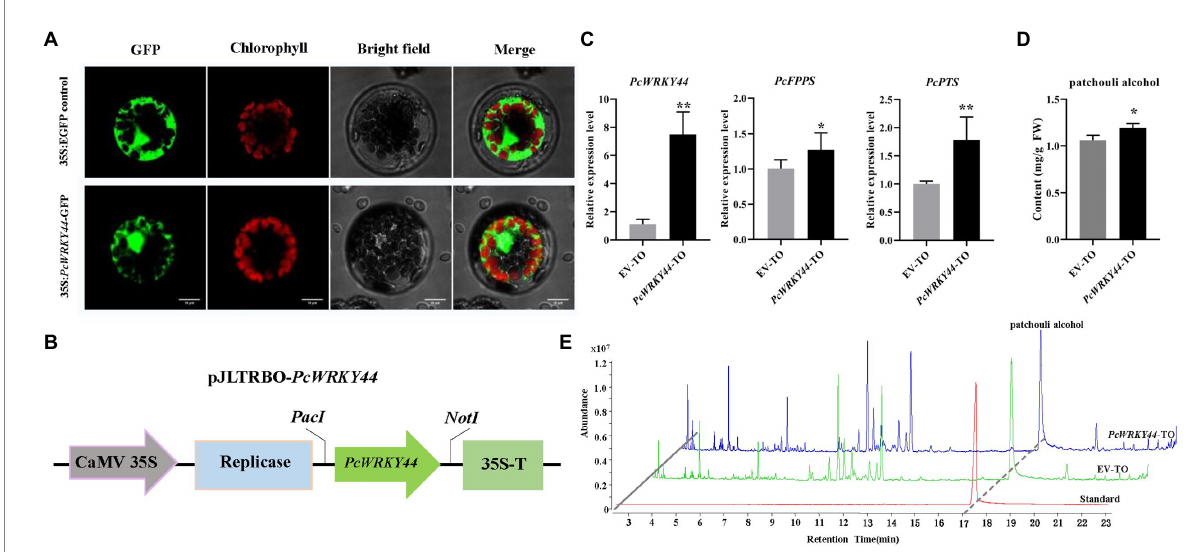
FIGURE 7 PcWRKY44 localized in the nucleus and transient overexpression of PcWRKY44 increased the accumulation of patchouli alcohol in P. cablin leaves. (A) Subcellular localization analysis of the 35S: PcWRKY44 -GFP fusion protein in Arabidopsis protoplasts. (B) Model of the pJLTRBO- PcWRKY44 constructs. The ORF of PcWRKY44 was cloned into the pJLTRBO vector with the restriction enzyme sites PacI and NotI . (C) The relative expression levels were analyzed by RT-qPCR for PcWRKY44 , PcFPPS, and PcPTS in EV-TO and PcWRKY44 -TO plants. (D) The content of patchouli alcohol detected in EV-TO and PcWRKY44 -TO leaves by GC-MS. (E) GC-MS chromatograms of samples from the standard, EV-TO, and PcWRKY44 -TO showing abundance of patchouli alcohol. Asterisks indicate a significant difference from the control (Student’s t -test; ** p < 0.01, * p < 0.05). Error bars are shown with the three biological